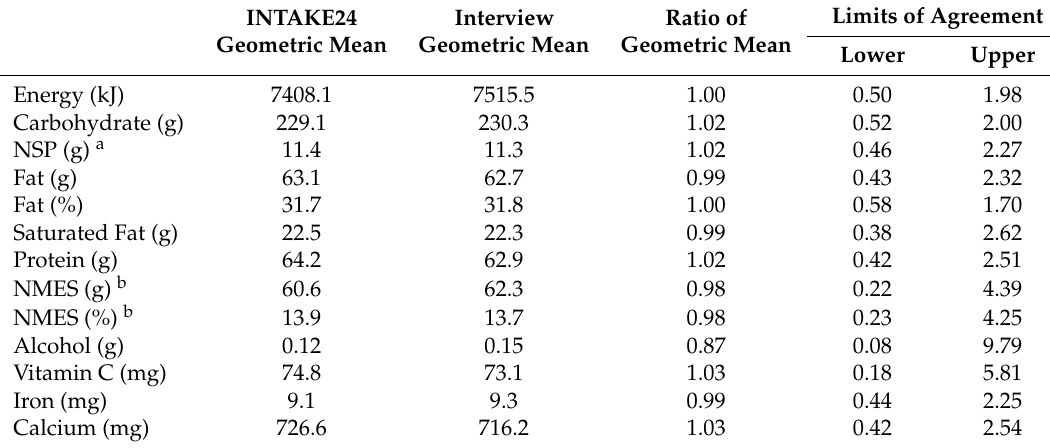
Table 3. Agreement of intakes reported using INTAKE24 with interviewer-led recalls for 17–24 years old (participants completing any number of days, n =